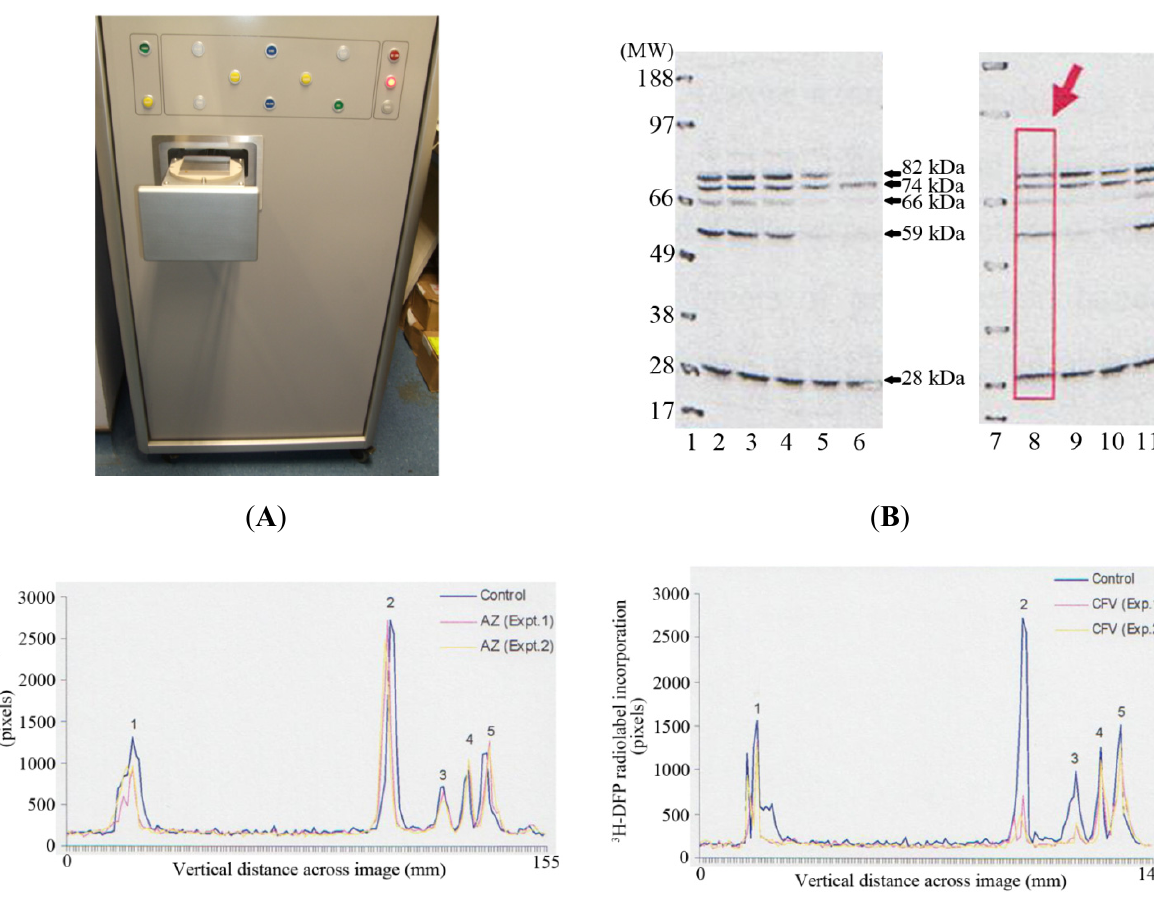
Figure 2. Detection and quantification of pesticide targets in vitro within rat thymus tissue using MCP autoradiography. ( A ) Photographic image of the front of the MCP imager with the loading drawer open to reveal the loading plate onto which a PVDF membrane or slides are applied. (B) An example of 1D PAGE and autoradiography. Gel lanes 1 and 7 are positions of the molecular weight markers. Gel lanes 2 and 8 are control thymus tissue protein radiolabelling levels. Gel lanes 3 and 4 are preincubations with azamethiphos-oxon at 35% and 89% tissue AChE inhibition respectively. Gel lanes 5 and 6 are preincubations with chlorpyrifos-oxon at tissue AChE inhibitions of 38% and 98% respectively. Gel lanes 9 and 10 are preincubations with chlorfenvinphos-oxon at tissue AChE inhibitions of 30 and 63% respectively. Gel lane 11 is a preincubation with malaoxon, at 70% tissue AChE inhibition. (C) Examples of the quantitation of radiolabel incorporated into protein targets 1–5 ( 3 H-DFP proteins of ~28, 59, 66, 74, and 82 kDa respectively) after preincubation with relatively low doses ( ≤ 30% tissue AChE inhibition) of azamethiphos-oxon. (D) Examples of the quantitation of radiolabel incorporated into protein targets 1–5 after preincubation with relatively low doses ( ≤ 30% tissue AChE inhibition) of chlorfenvinphos-oxon. For plotting, the background autoradiographic intensity at each pixel measurement within a gel lane was subtracted from the test level recorded. The results shown are representative of at least 10 independent experiments with each of the